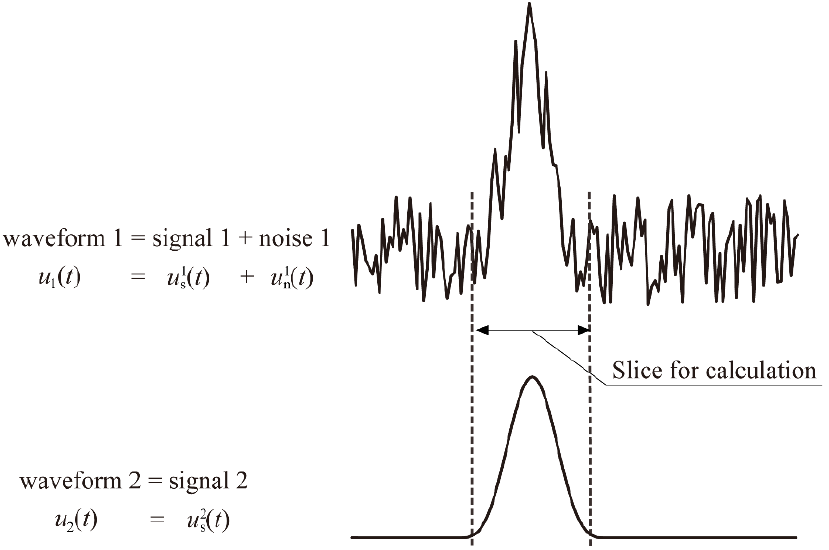
Figure 2. Comparison between the two waveforms recorded by two sensors. Waveform 2 with the optimal signal-to-noise ratio is regarded as the correlation function.